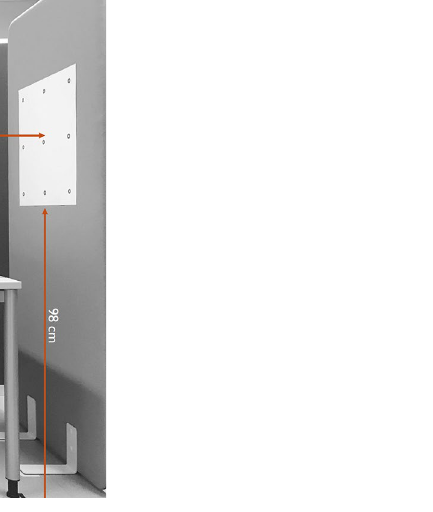
Figure 1. Illustration of the scene setup with relevant